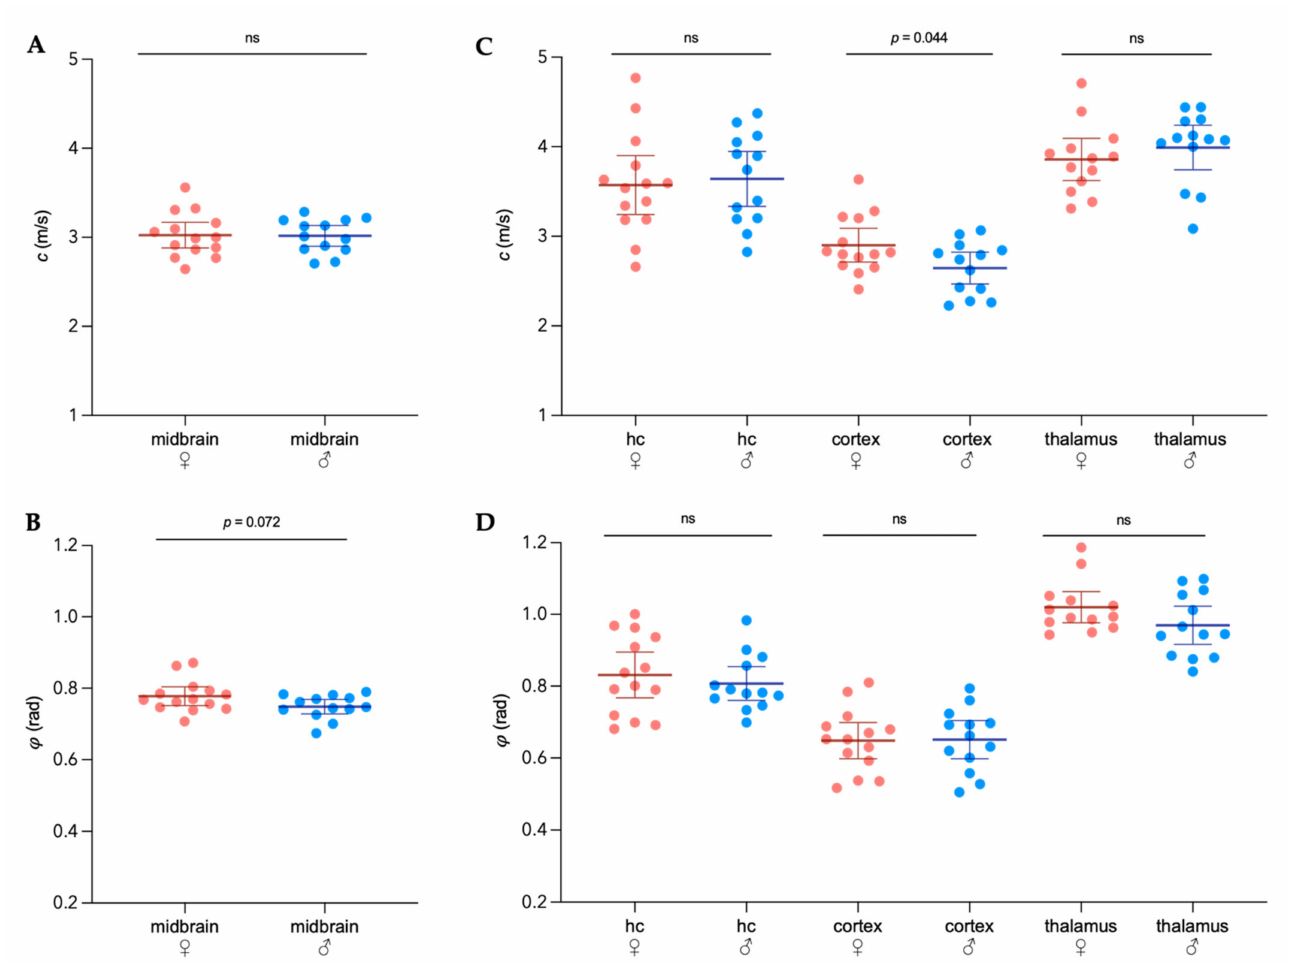
Figure 2. Sexual dimorphism in viscoelastic properties of healthy adult mouse brains. Mean shear wave speed c in m/s ( A ) and fluidity ϕ in rad ( B ) in the whole coronal section of the midbrain of female and male mice. ( C ) Regional analysis of stiffness ( c ) between sexes in the cortex, hippocampus, and thalamus. ( D ) Regional assessment of fluidity ( ϕ ). n female = 14, n male = 13, hc = hippocampus; representation of individual data points with mean and 95% CI. Group comparison performed by t test. ns = not